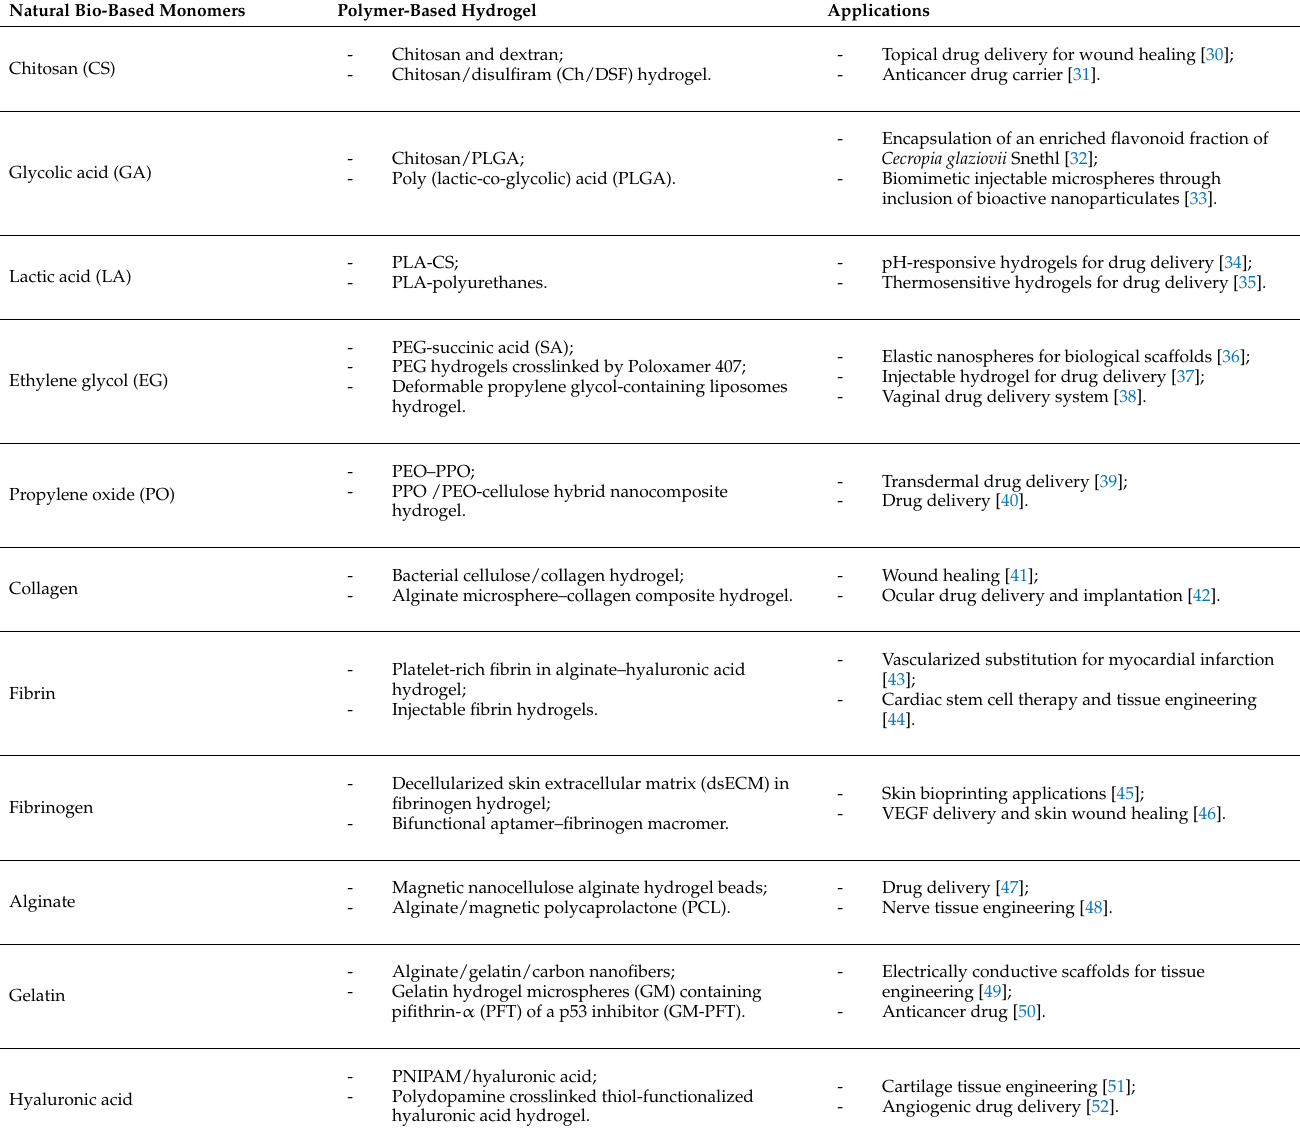
Table 1. Examples of natural bio-based monomers, their most used copolymers and main applications in the biomedical